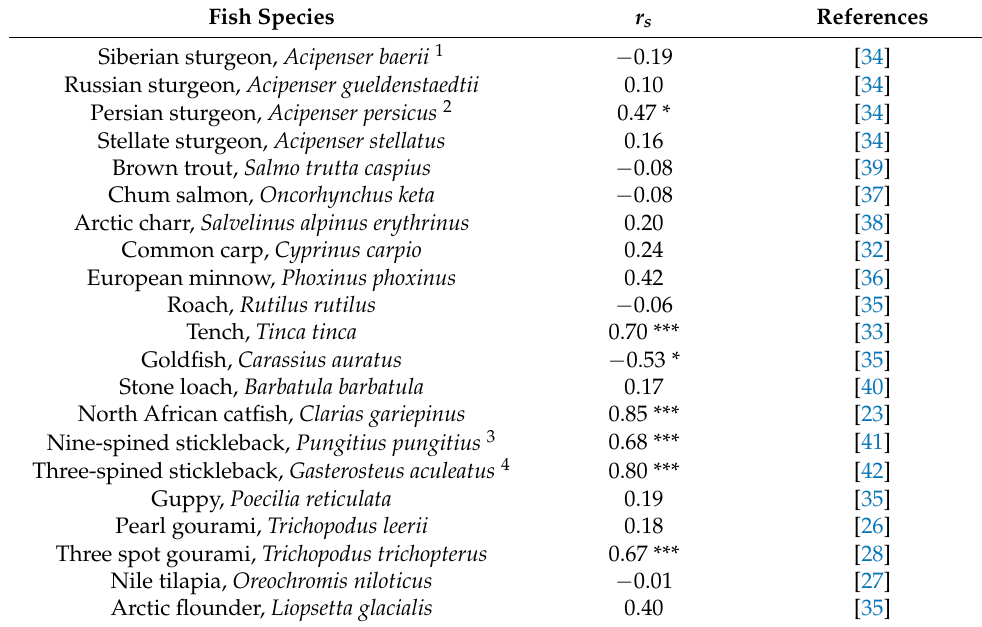
Table 2. The values of Spearman rank correlation coefficient for taste preferences to 21 free L-amino acids between barramundi Lates calcarifer and other fish